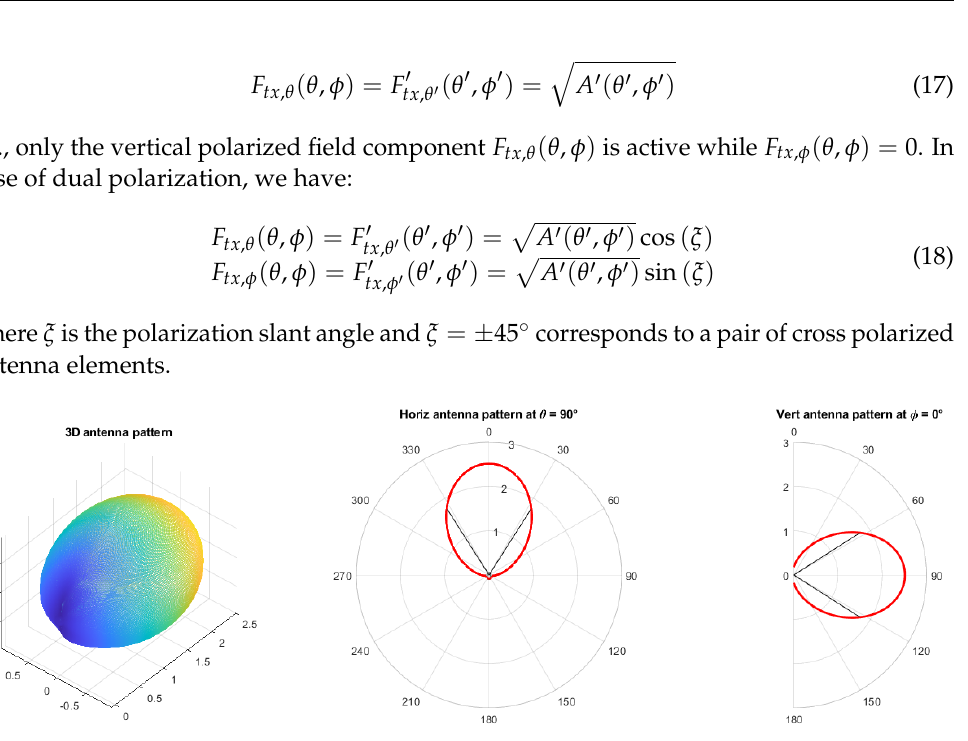
Figure 3. 3GPP antenna element radiation